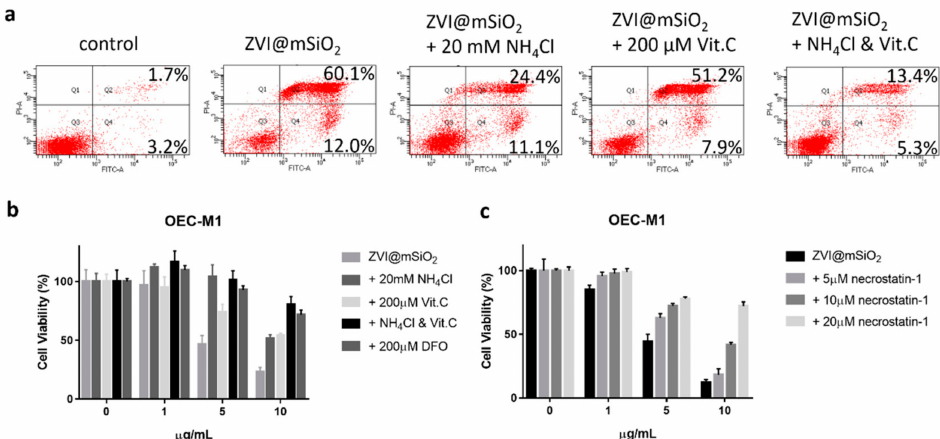
Figure 5. Necrosis and apoptosis induced by ZVI@mSiO 2 in OEC-M1 cells could be rescued